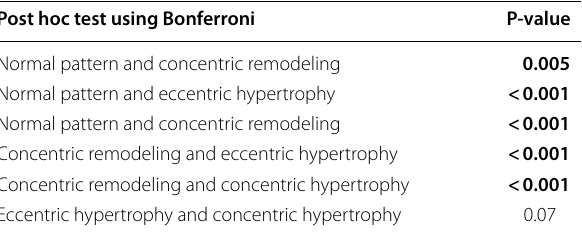
Table 7 Comparison in-between the different LV geometric patterns regarding the LV mass index